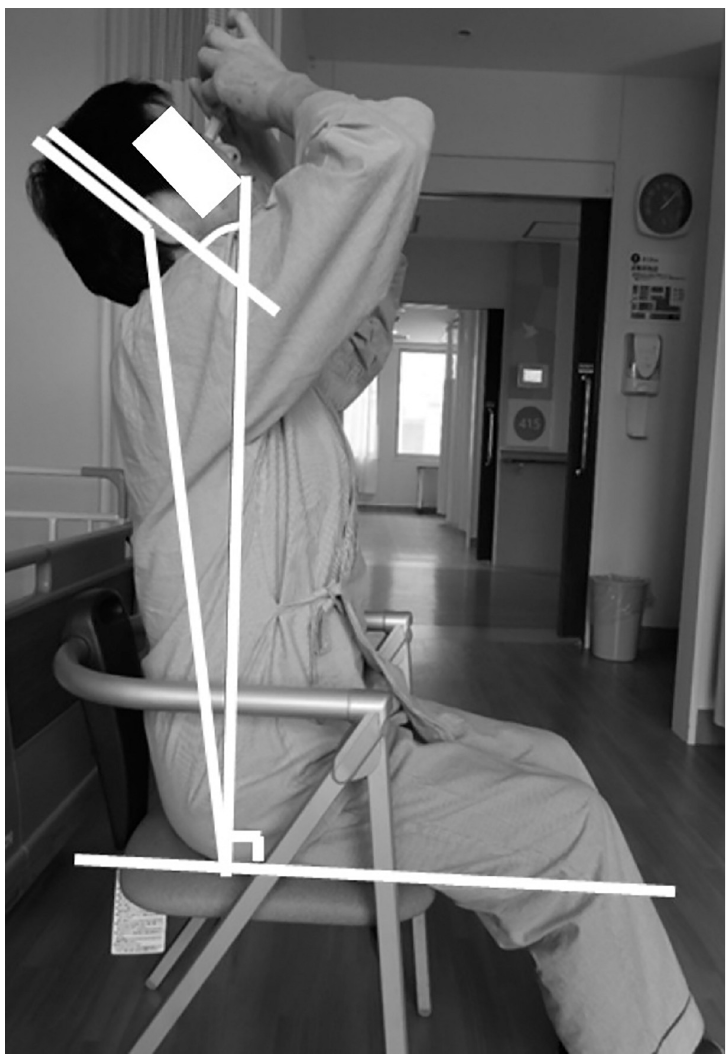
Fig 1. Measurement of the cervical spine extension angle. The cervical spine extension angle (a) is defined as the angle formed by the line connecting the perpendicular to the chair and the parietal